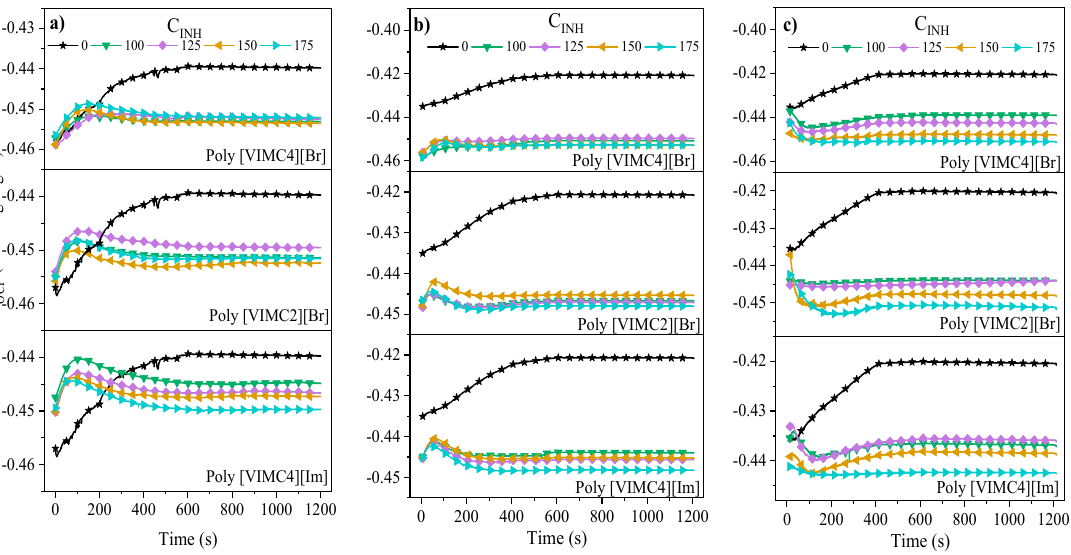
Figure 2. E OCP as a function of the immersion time of API 5L X60 steel in 1 M H 2 SO 4 in the absence and presence of PILs as CIs at: ( a ) 308, ( b ) 318 and ( c ) 328 K.